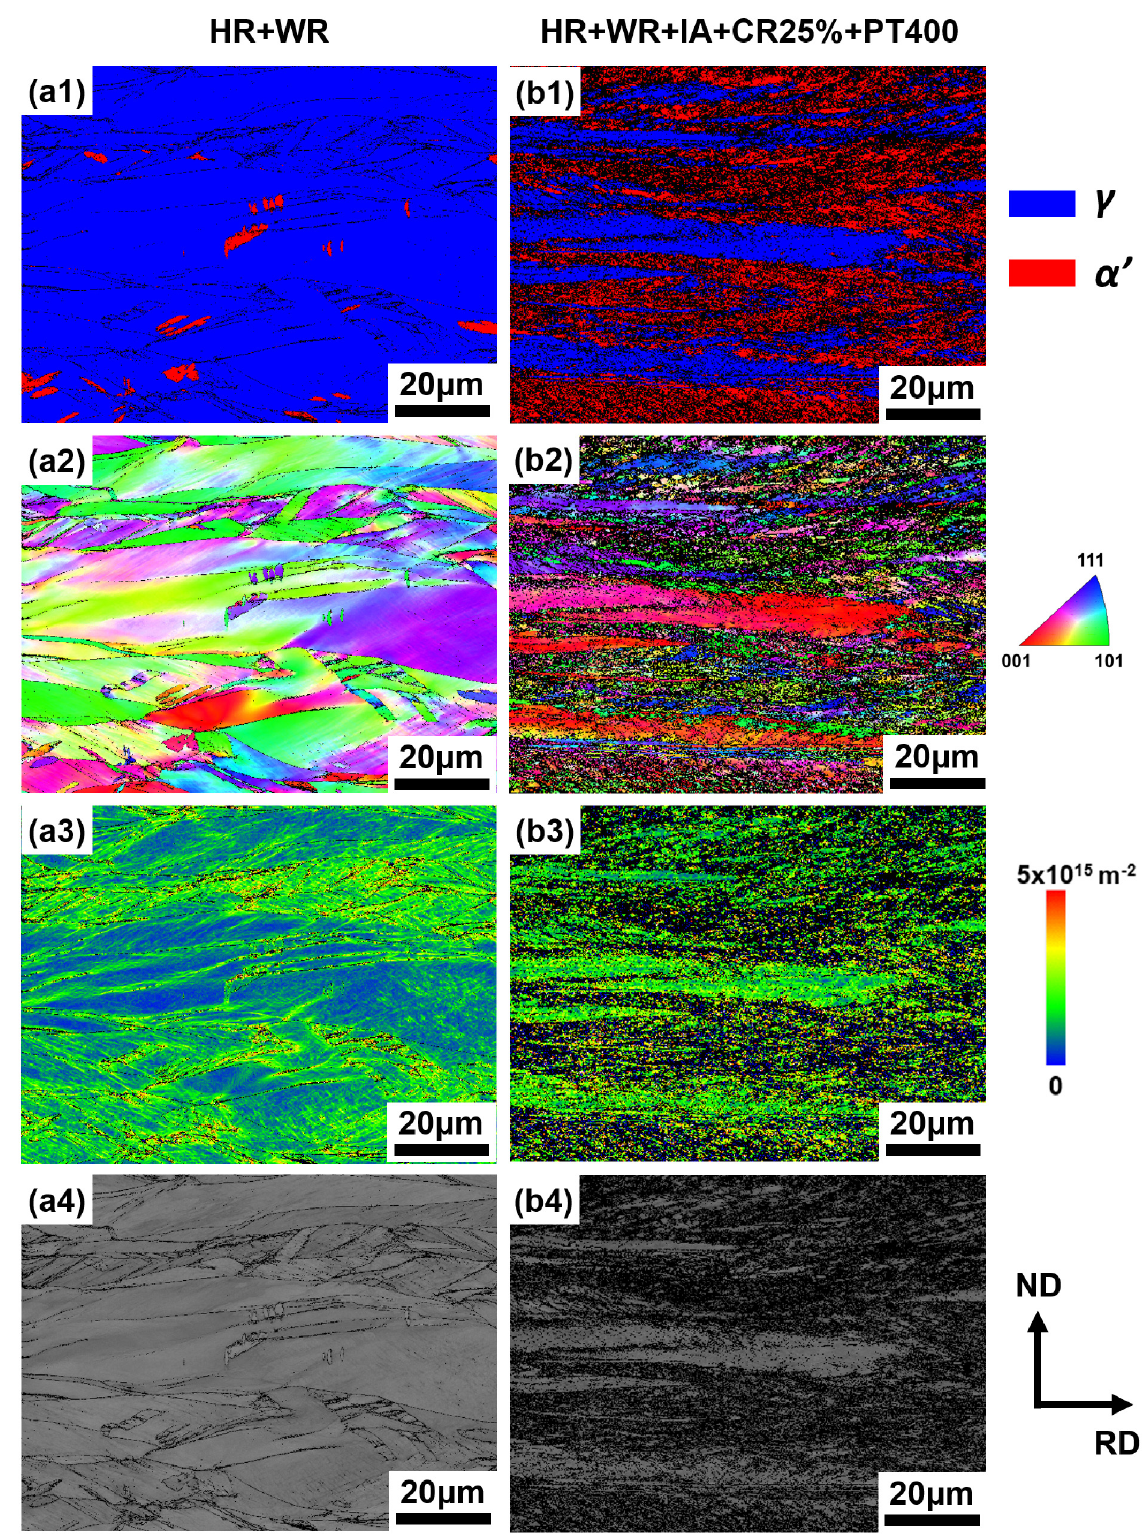
Figure 4. Electron backscatter diffraction (EBSD) maps showing the initial microstructures of the HR + WR sample ( a1 – a4 ) and HR + WR + IA + CR25% + PT400 sample ( b1 – b4 ). Therein, ( a1 , b1 ) are the phase maps showing the phase distribution of the two samples. ( a2 , b2 ) are the inverse pole figure (IPF) maps showing the grains orientations of the two samples. ( a3 , b3 ) are the maps of geometrically necessary dislocation (GND) density, estimated based on the kernel average misorientation. ( a4 , b4 ) are the band contrast maps showing image quality of the mapping. RD: rolling direction, ND: normal direction. γ : austenite, α ’: martensite.